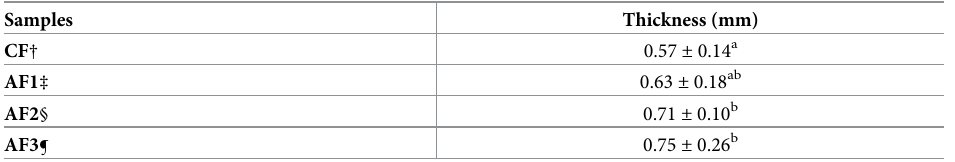
��� Each value represents the mean of 15 replicates with corresponding standard deviation. Data were statistically analyzed with multiple range test, using the method of least significant difference (LSD) Fisher. Different lowercase letters denote statistically significant differences (p < 0.05).